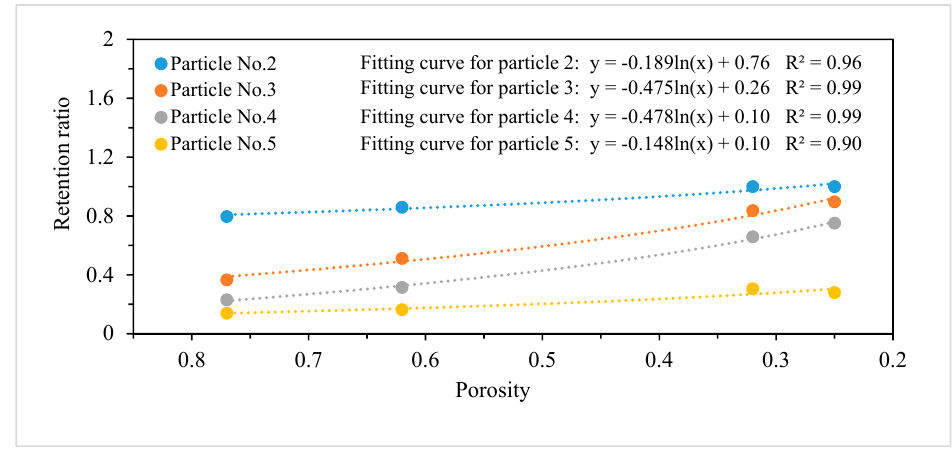
Figure 4. Retention ratio of the geotextile layer for particulate matter of different sizes under different porosities.